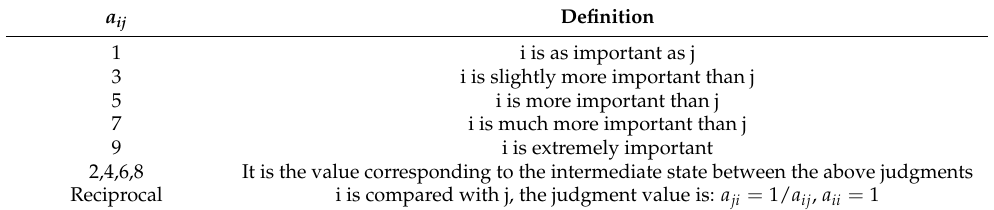
Table 5. Scale value table.